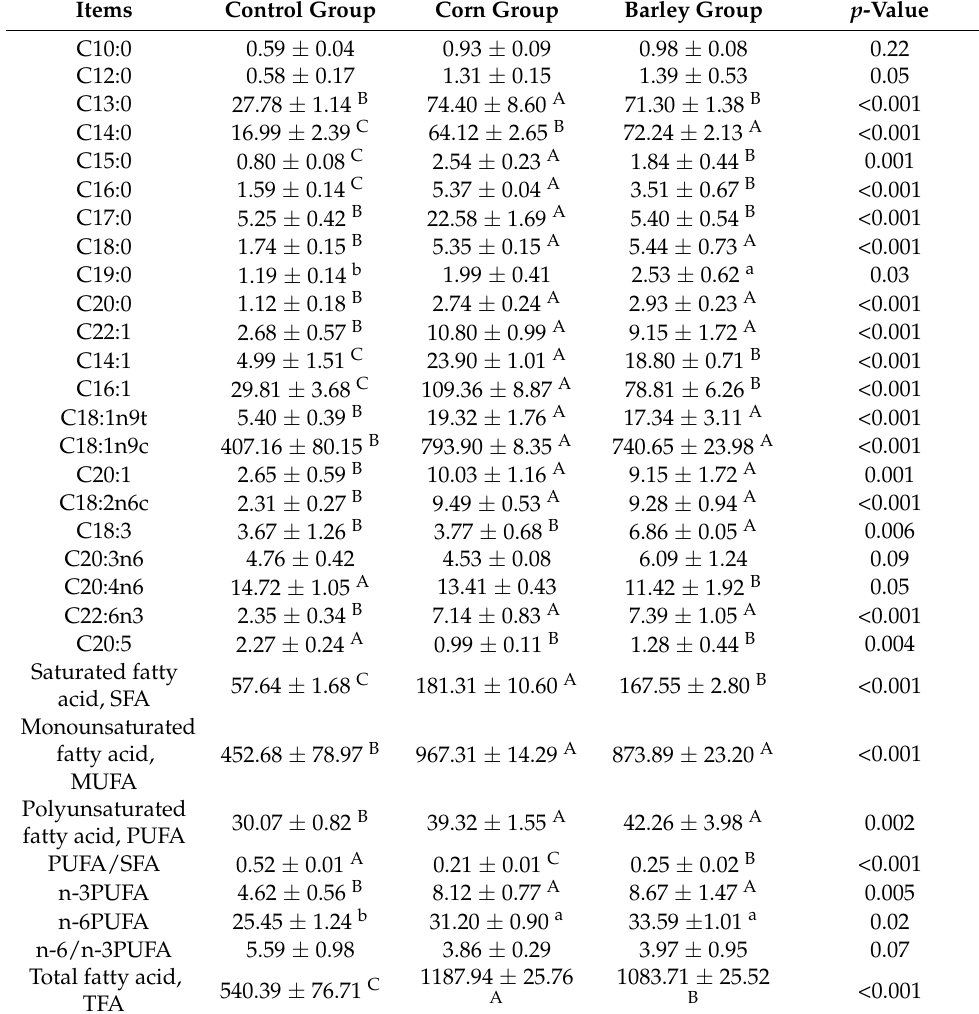
Table 10. Effects of different carbohydrate source diets on fatty acid composition and content 524 (mg/100 g) in